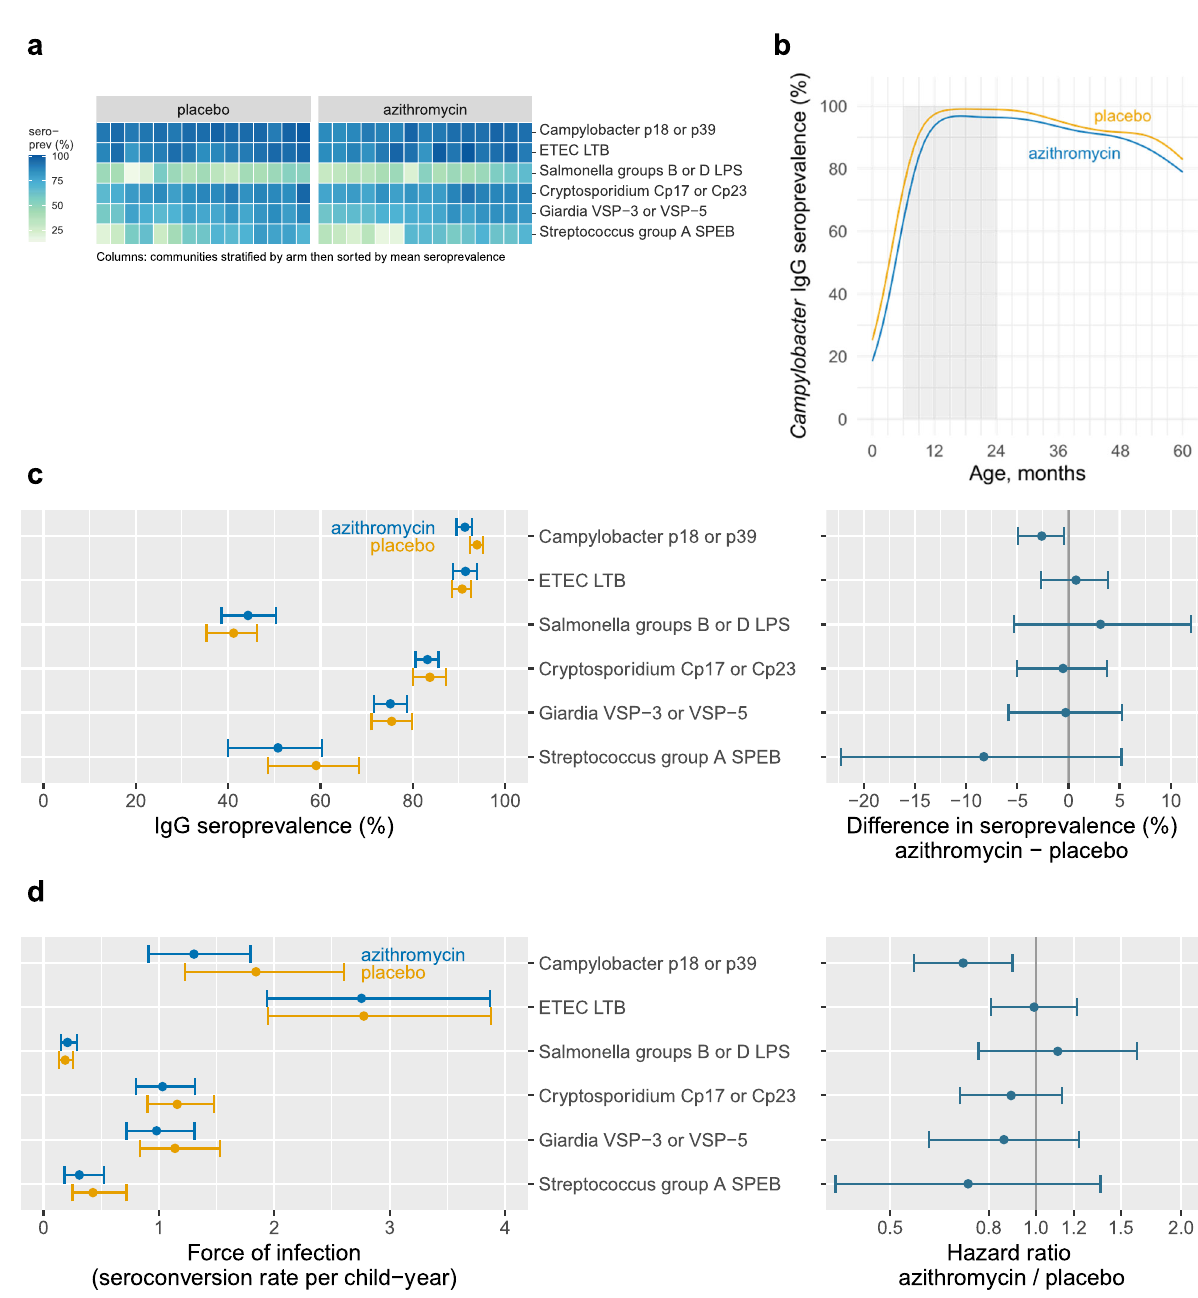
Fig. 3 Bacterial and protozoan IgG antibody responses by treatment group. Estimates from 4265 children ages 6 – 59 months in the MORDOR Niger trial, 2015 – 2018. a Community-level seroprevalence to bacterial and protozoan antigens. Columns represent individual communities, which were strati fi ed by treatment group and then sorted by overall mean seroprevalence. b IgG seroprevalence to Campylobacter spp. p18 or p39 antigens by age and treatment group (lines), estimated with semiparametric splines. The shaded region from 6 to 24 months indicates the age range included in force of infection analyses, based on a pre-speci fi ed rule ( n = 1496). c Pathogen-speci fi c IgG seroprevalence by treatment group and the difference between groups ( n = 4265 children ages 6 – 59). Points indicate group means and mean the difference between groups, error bars indicate 95% con fi dence intervals. d Pathogen-speci fi c force of infection estimated by the seroconversion rate, and hazard ratio for comparison between groups. Antibody responses were measured from 1496 children ages 6 – 24 months ( n = 4265 children ages 6 – 59 months for Salmonella and Streptococcus ), based on pre-speci fi ed age restrictions. Points indicate group means and the hazard ratio between groups, error bars indicate 95% con fi dence intervals. The reduction in Campylobacter spp. seroconversion rate remained statistically signi fi cant after false-discovery rate correction. ETEC enterotoxigenic E. coli . Created with notebooks https://osf.io/b2v3r, https://osf.io/smwbn, https://osf.io/fwxn5, which include detailed point estimates and additional, consistent results based on geometric mean IgG